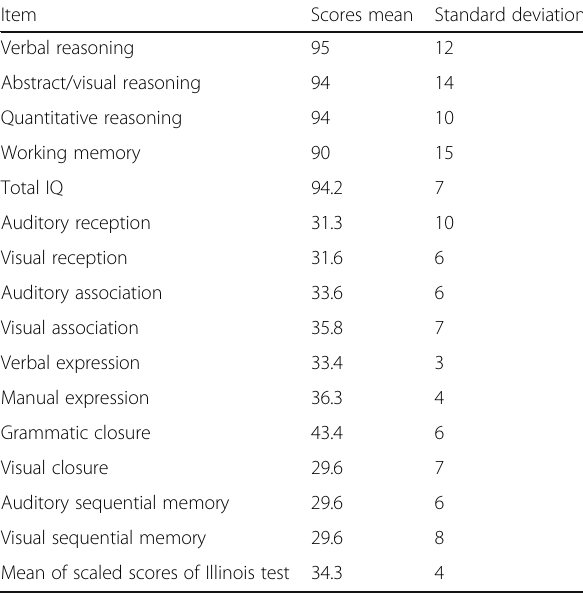
Table 1 Mean and standard deviation of IQ scores, subtests of SB-IV, and the scaled scores Illinois Test of Psycholinguistic Abilities subtests for the specific learning disorder group